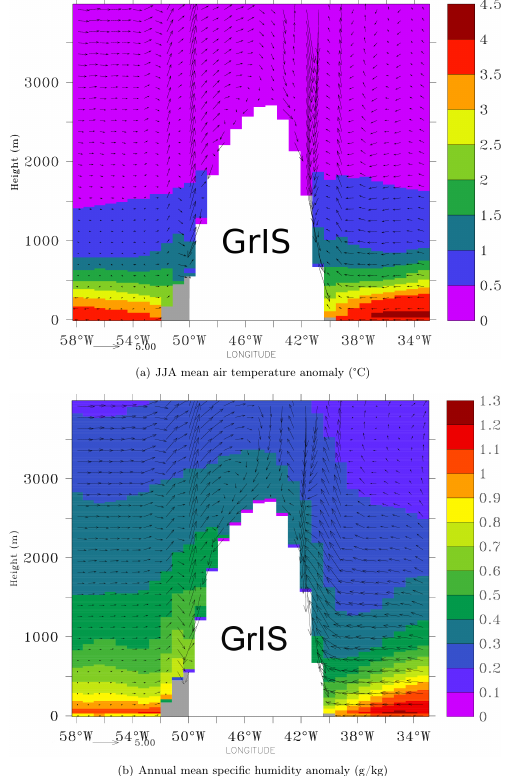
Figure 6. Longitudinal section through the GrIS (64 ◦ N), showing in the background (a) the difference between JJA mean air tem- perature ( ◦ C) from the SIC − 6/SST + 4 and the reference run, (b) same for annual mean specific humidity (gkg − 1 ). The over- laid vectors represent (a) JJA mean wind speed (ms − 1 ) for the reference run over 2007–2012, (b) same for annual mean. The wind speed can be estimated using the arrow size (5ms − 1 ) beneath the graphs. The grey area corresponds to the tundra region surrounding the